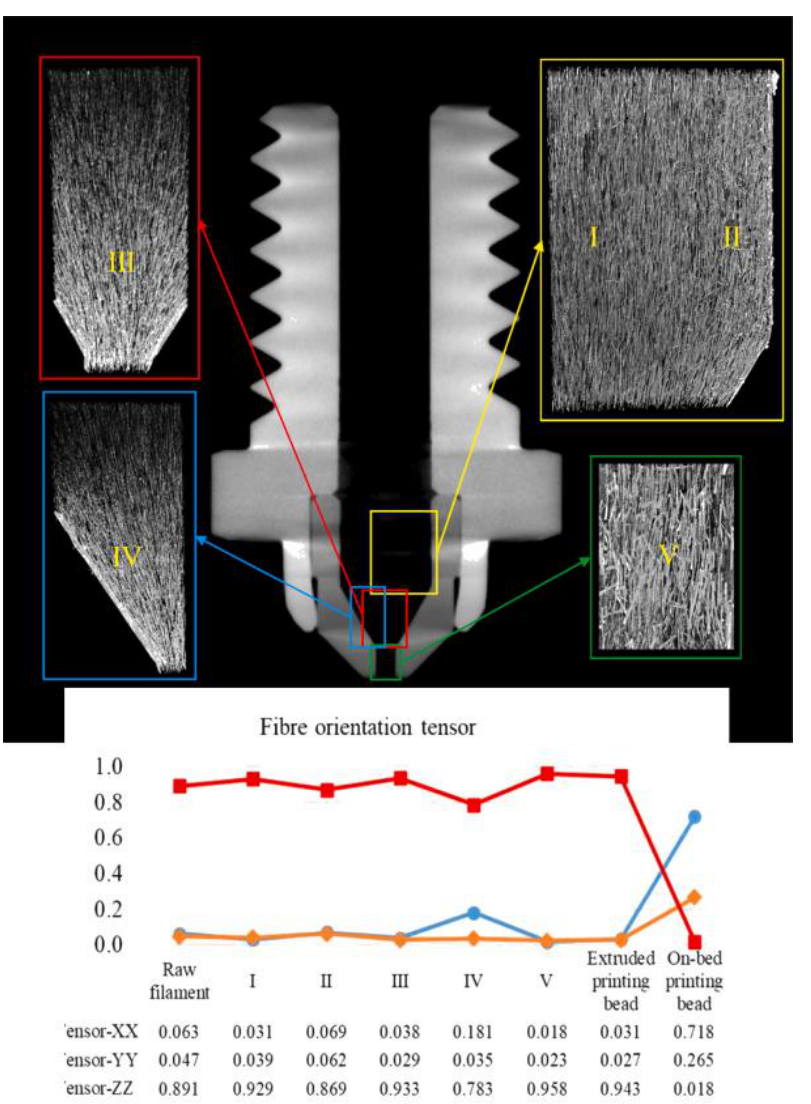
Figure 5. Fiber orientation tensor evaluation along an FFF extrusion nozzle [94].